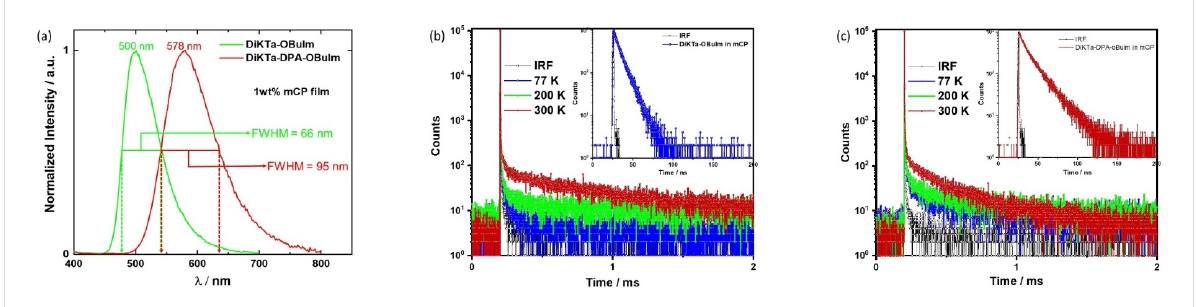
Figure 4: (a) Steady-state emission spectra of DiKTa-OBuIm and DiKTa-DPA-OBuIm in 1 wt % doped mCP films, λ exc. = 340 nm; (b) temperature- dependent time resolved PL decays of DiKTa-OBuIm in 1 wt % doped mCP films. Inset: prompt PL decay of DiKTa-OBuIm; (c) temperature-depend-